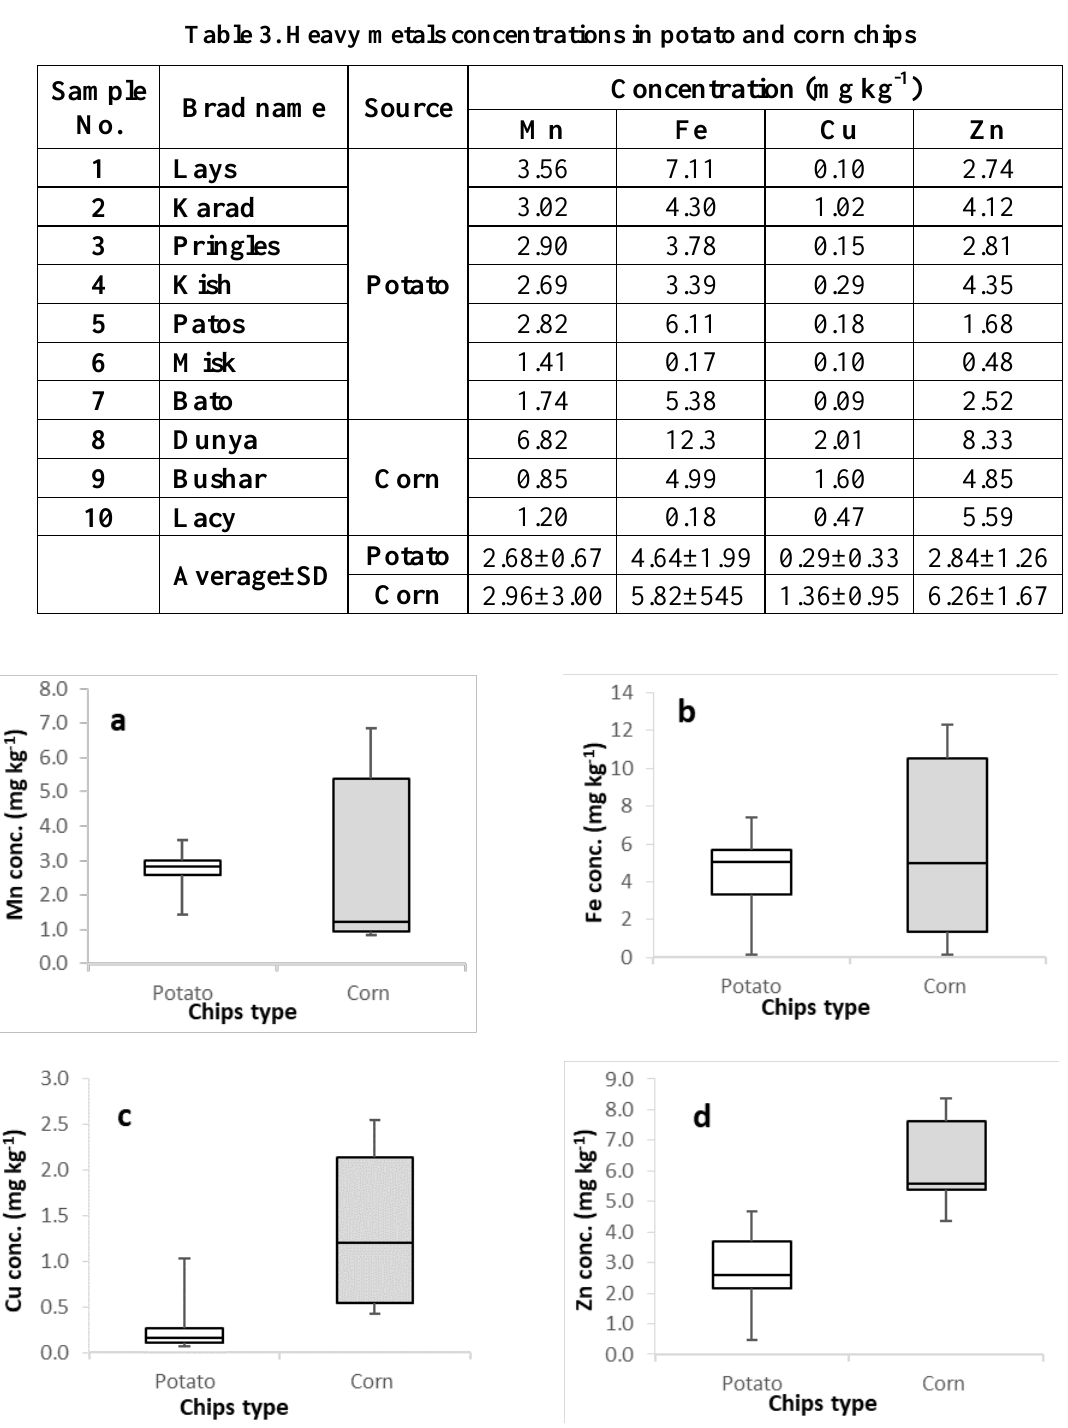
Figure 1. The concentration of heavy metals in the studied potato and corn chips; the figure shows the deference of heavy metals level between potato chips and corn based